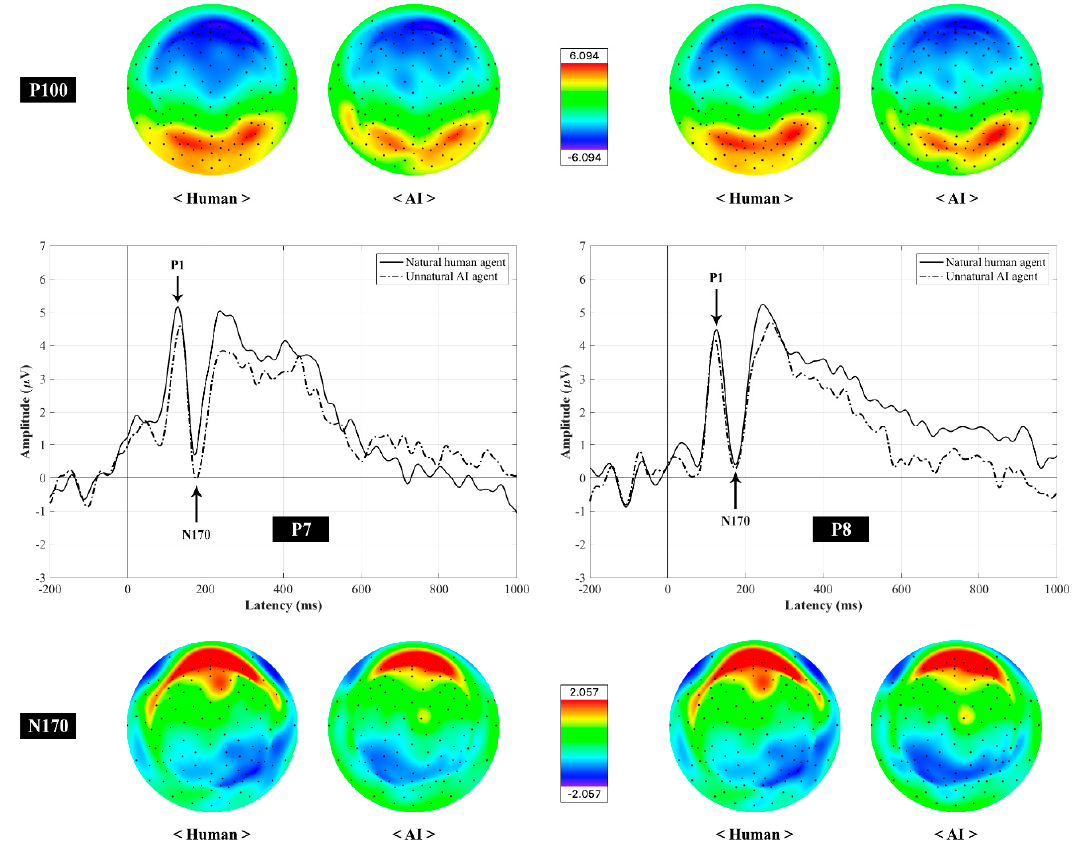
Figure 3. Grand averaged ERP waveforms and topographical maps of P1 (P100) and N 170 recorded at P7 and P8 electrode sites, elicited by two different agent stimuli associated with images and words.